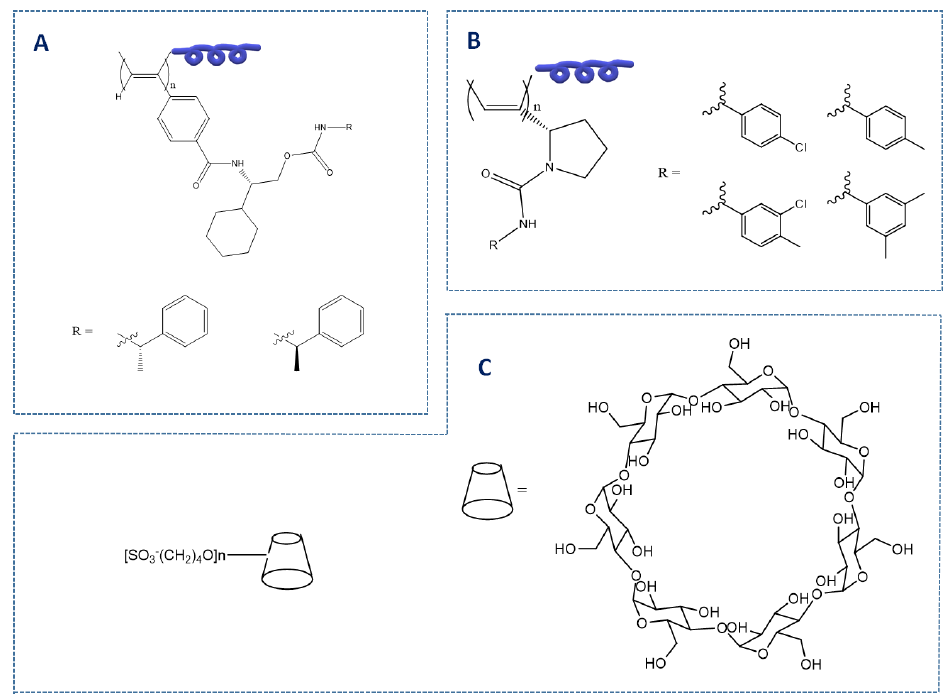
Figure 2. Recent selectors ( A – C ) for chiral stationary phases prepared by coating method.